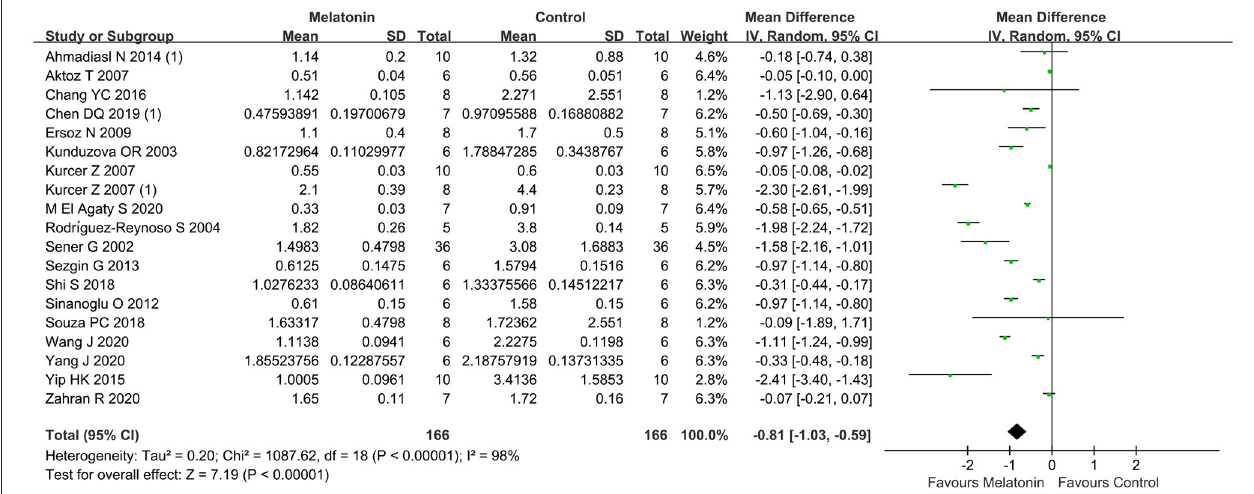
FIGURE 3 | Forest plot for the effects of melatonin on serum creatinine.